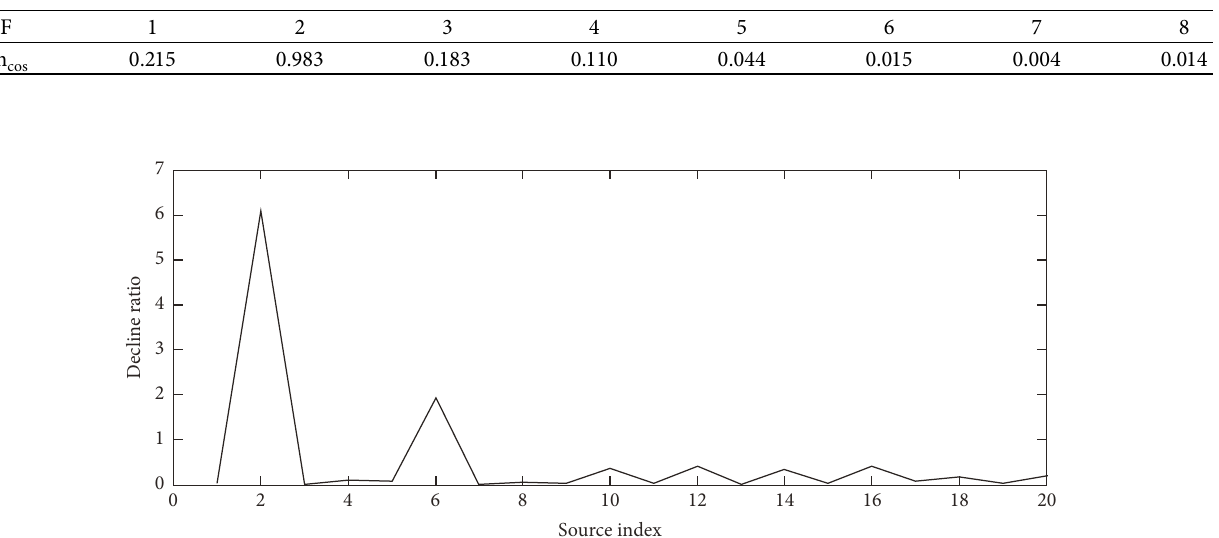
Table 4: Cosine similarities between each IMF and the mixed signal in Figure 4(b).